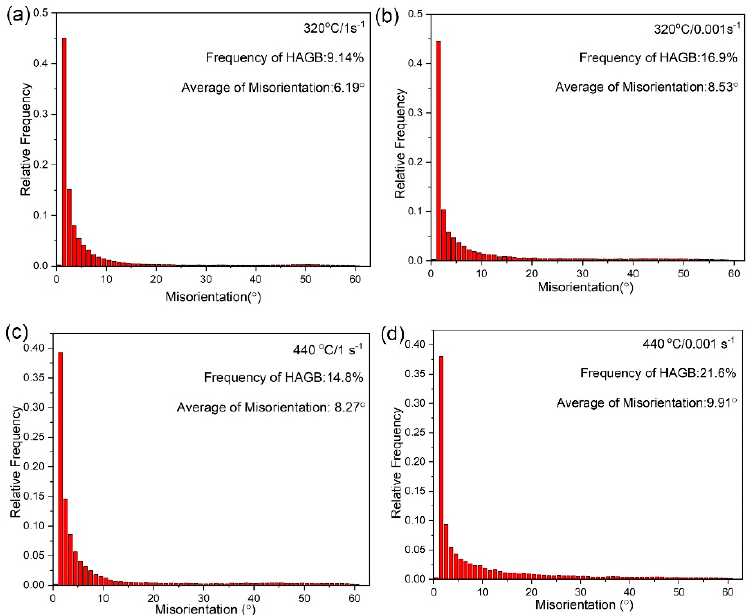
Figure 12. Misorientation angle distribution histograms of the samples: ( a ) 320 °C/1 s − 1 ; ( b ) 320 °C/0.001 s − 1 ; ( c ) 440 °C/1 s − 1 ; ( d ) 440 °C/0.001 s − 1 . ( b ) 320 ◦ C/0.001 s − 1 ; ( c ) 440 ◦ C/1 s − 1 ; ( d ) 440 ◦ C/0.001 s − 1